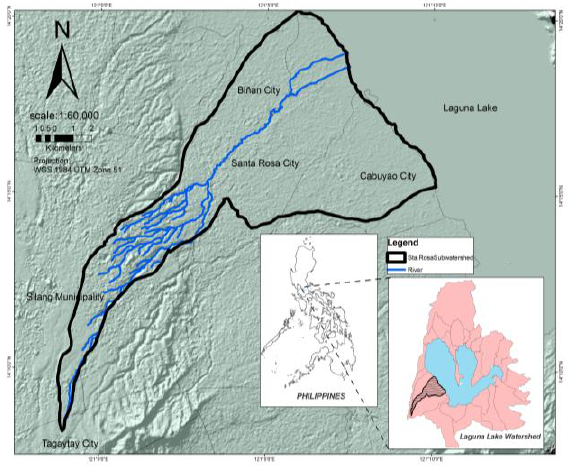
Figure 1. Location map of the study area.